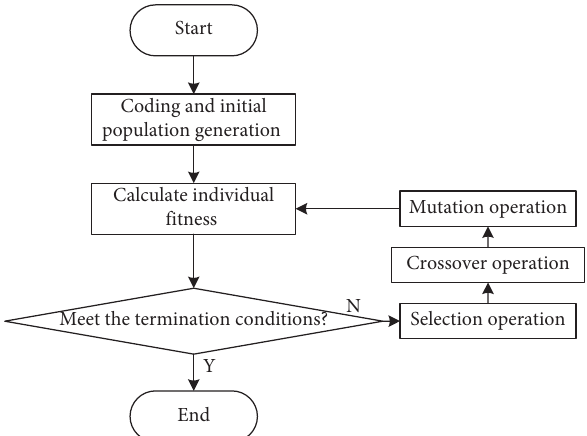
Figure 2: Flow chart of basic genetic